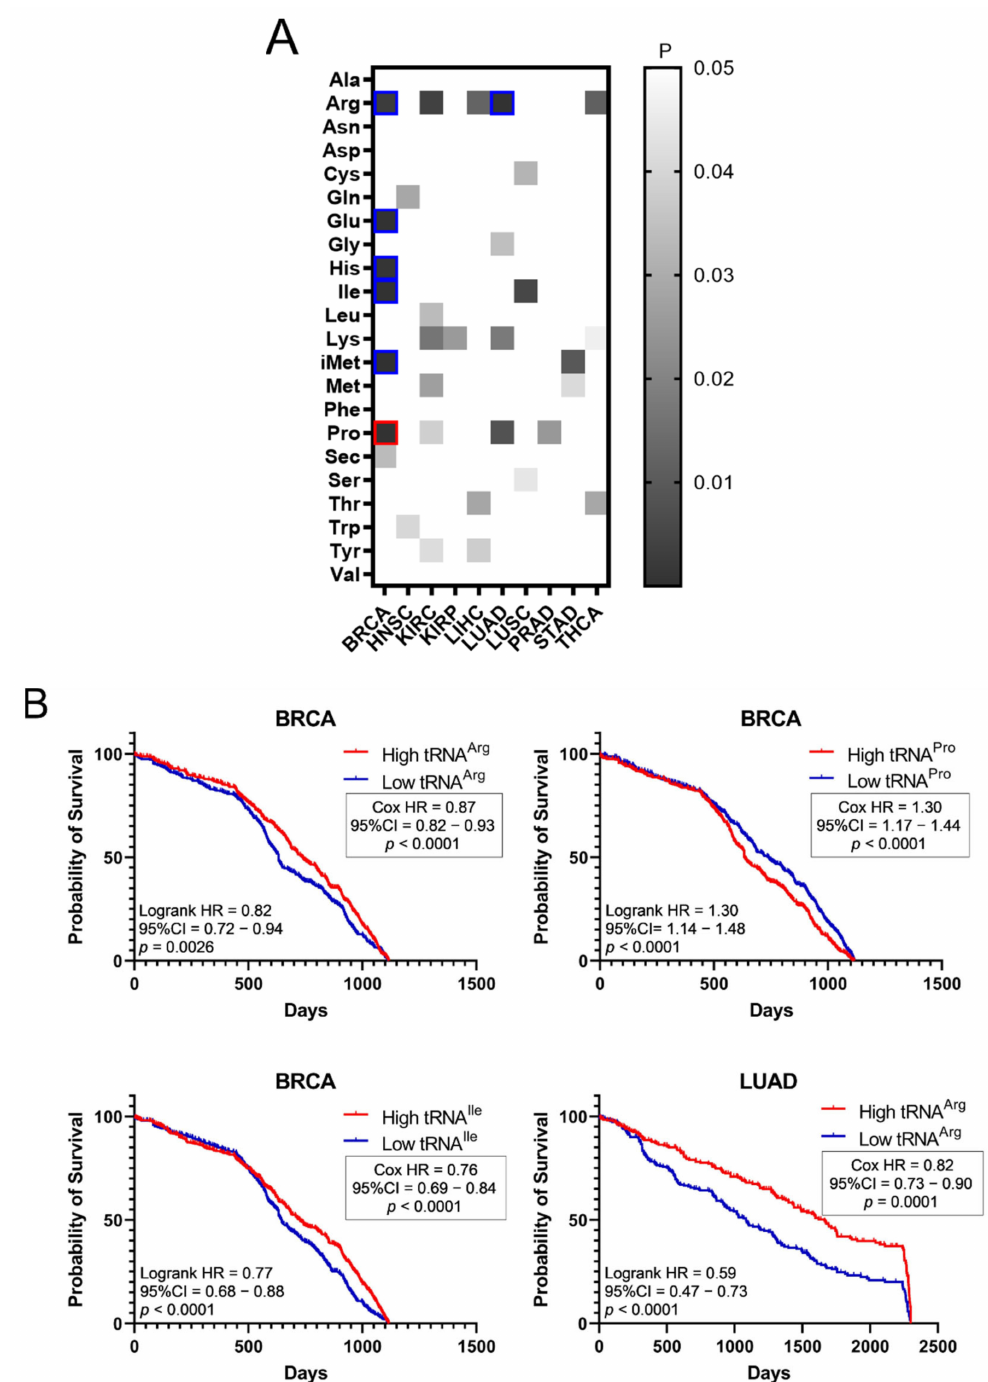
Figure 5. Survival of patients with upregulated or downregulated tRNA expression. ( A ) Patient survival p -values (logrank test) in tumours with upregulated or downregulated tRNA expression. The grey squares represent p < 0.05. The red outlines represent q < 0.05 for tRNAs whose overexpression correlated with worse patient survival, while the blue outlines represent q < 0.05 for tRNAs whose downregulation correlated with worse patient survival. ( B ) Indicative Kaplan–Meier survival plots of patients with tumours presenting upregulated or downregulated tRNA